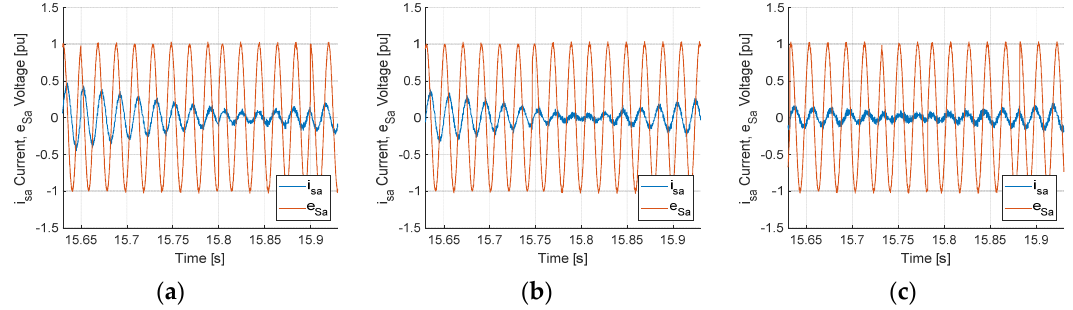
Figure 15. One phase grid current in changing mode: ( a ) CHB (4000 µ F ) ; ( b ) CHB ( 1200 µ F ) ; ( c ) CHB-SDC ( 1200 µ F ) .